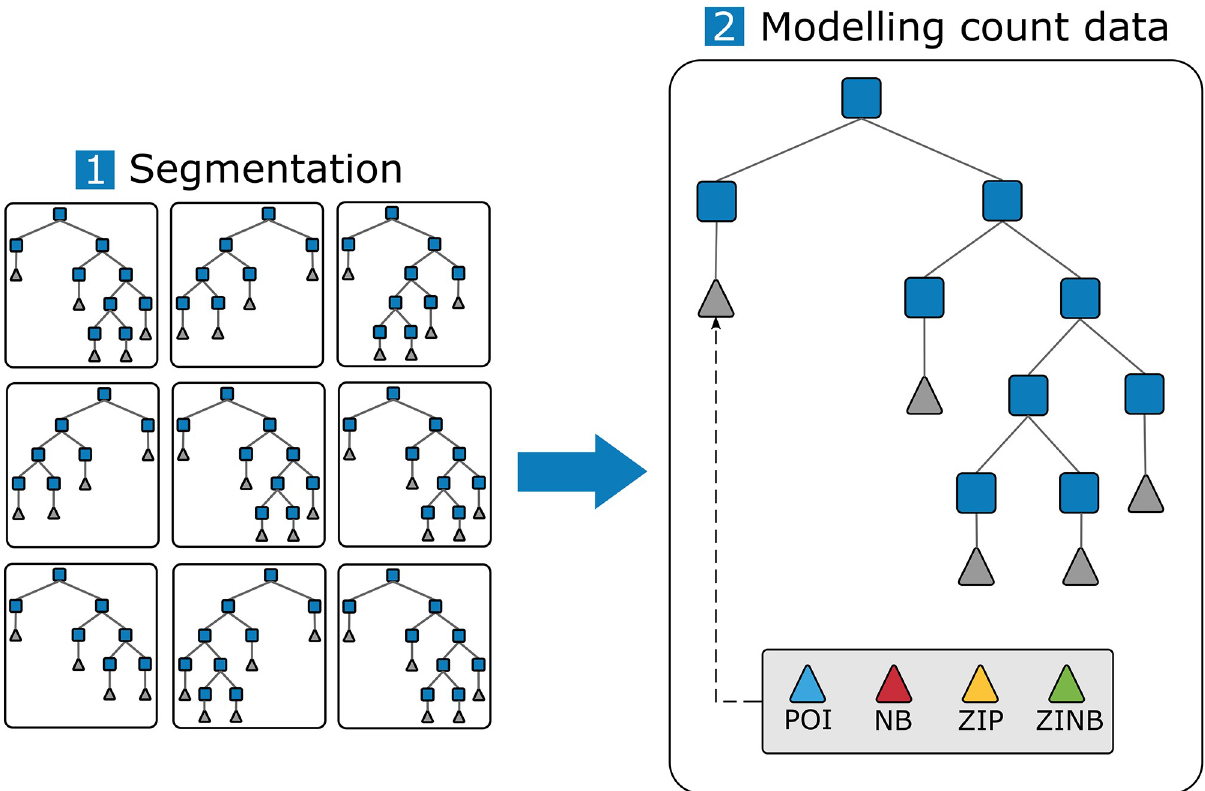
Fig 4. Proposed approach to couple RF and count data models (Poisson: POI, negative binomial: NB, zero-inflated Poisson: ZIP, and zero- inflated negative binomial: ZINB). First, the ensemble of decision trees is used to segment the samples into groups with similar characteristics. These trees are shallow trees, so that each of the leaf nodes contains a few hundred of samples. Second, we plug the selected count data models to each of the leaf nodes in the ensemble. The predictions yielded by the count data models are subsequently averaged to obtain the final prediction for each RF and count data model